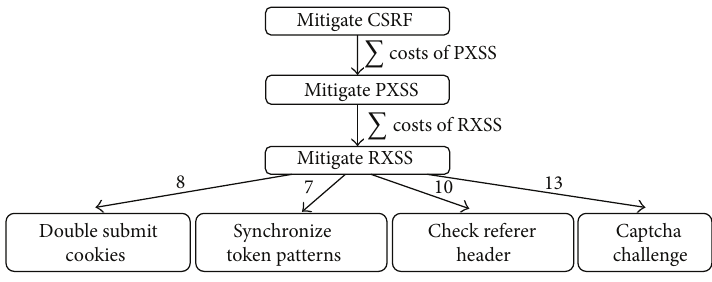
Figure 5: Mitigation tree of the CSRF attack pattern.